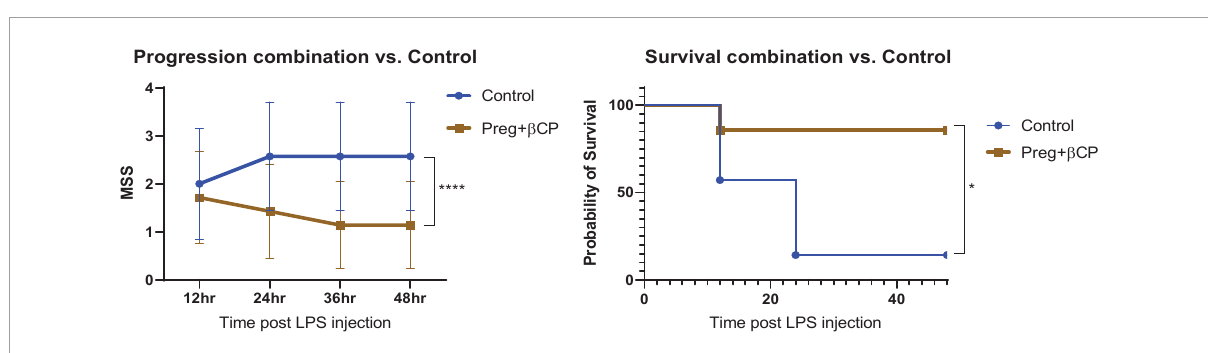
FIGURE2 All groups were injected with LPS 25 µ g/g. Mice were pre-treated with β -caryophyllene (BCP, 25 mg/kg) and Pregnenolone (Preg, 10 mg/kg) 24 and 12 h before LPS injection and then every 12 h. N = 7. **** p < 0.0001, 2-way ANOVA for disease progression; * p = 0.0152, Log-rank (Mantel-Cox) test for